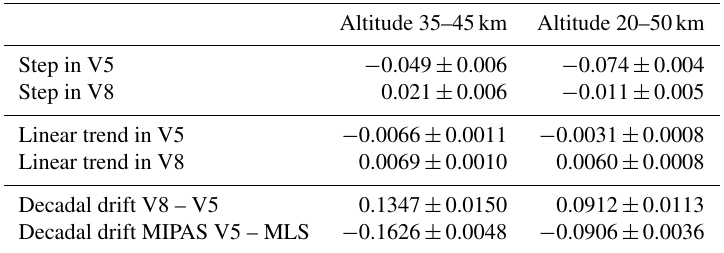
Table 4. Mean values of the fit parameter step between FR and RR measurements and of the fit parameter linear trend (see text for details). The step in vmr is given in parts per million by volume (ppmv), the linear trend values in ppmv per year, and the decadal drift (linear trend in version 8 minus linear trend in version 5) in ppmv per decade. Values for the decadal drift MIPAS version 5 minus MLS (v2.2 data) are calculated from the data which were used for Fig. 4 of Eckert et al. (2014) and which rely on more sophisticated methods for trend estimation than used in this work. Errors are standard errors of the